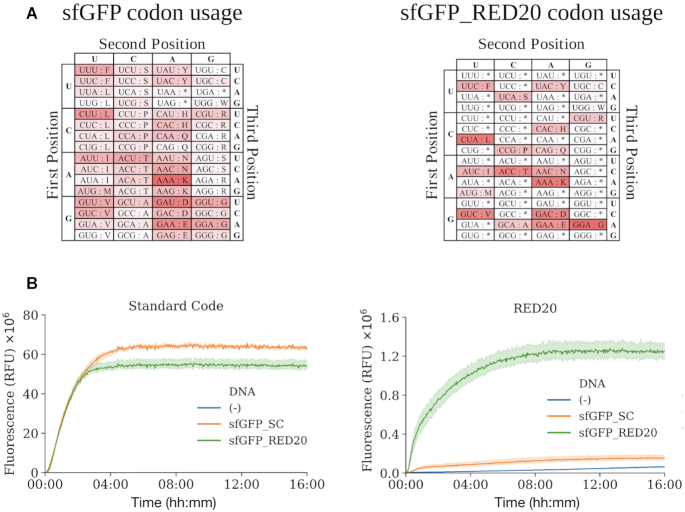
A reduced set of tRNA encoding RED20 can express a functional fluorescent protein. (A) Frequency of codon usage in coding sequences for super folder variants of GFP (sfGFP) encoded in either the Standard Code (sfGFP_SC, left) or RED20 (sfGFP_RED20, right). Unused codons are represented in white, while frequently used codons are represented in red. (B) Fluorescence versus time for sfGFP encoded in the Standard Code (orange, n = 3) or in RED20 (green, n = 4) expressed in vitro from a tRNA set encoding either the Standard Code (left) or RED20 (right). Reactions without template DNA were included as negative controls (blue, n = 3). Mean fluorescence for a given condition, averaged across replicates (bold lines) and standard deviation across replicates (shaded regions) are shown.